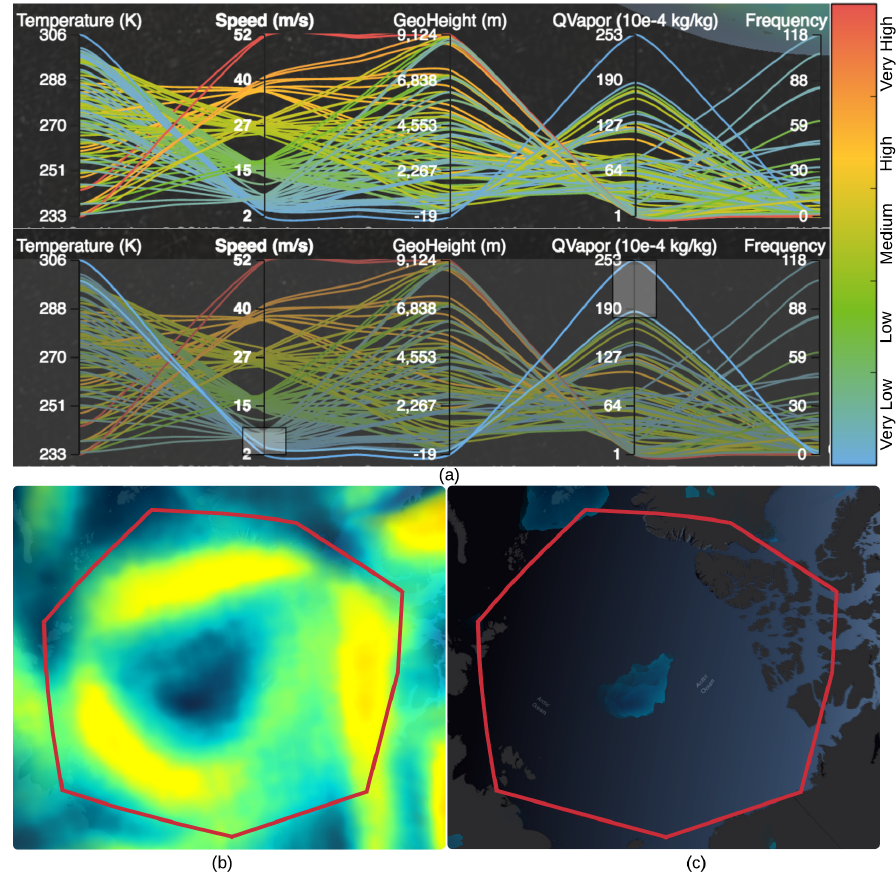
Figure 3. Illustration of the interaction of the spatial view and parallel coordinate plot (PCP) view: ( a ) multifaced PCP view; ( b ) user interacts in the spatial view; ( c ) updating of the spatial view along with